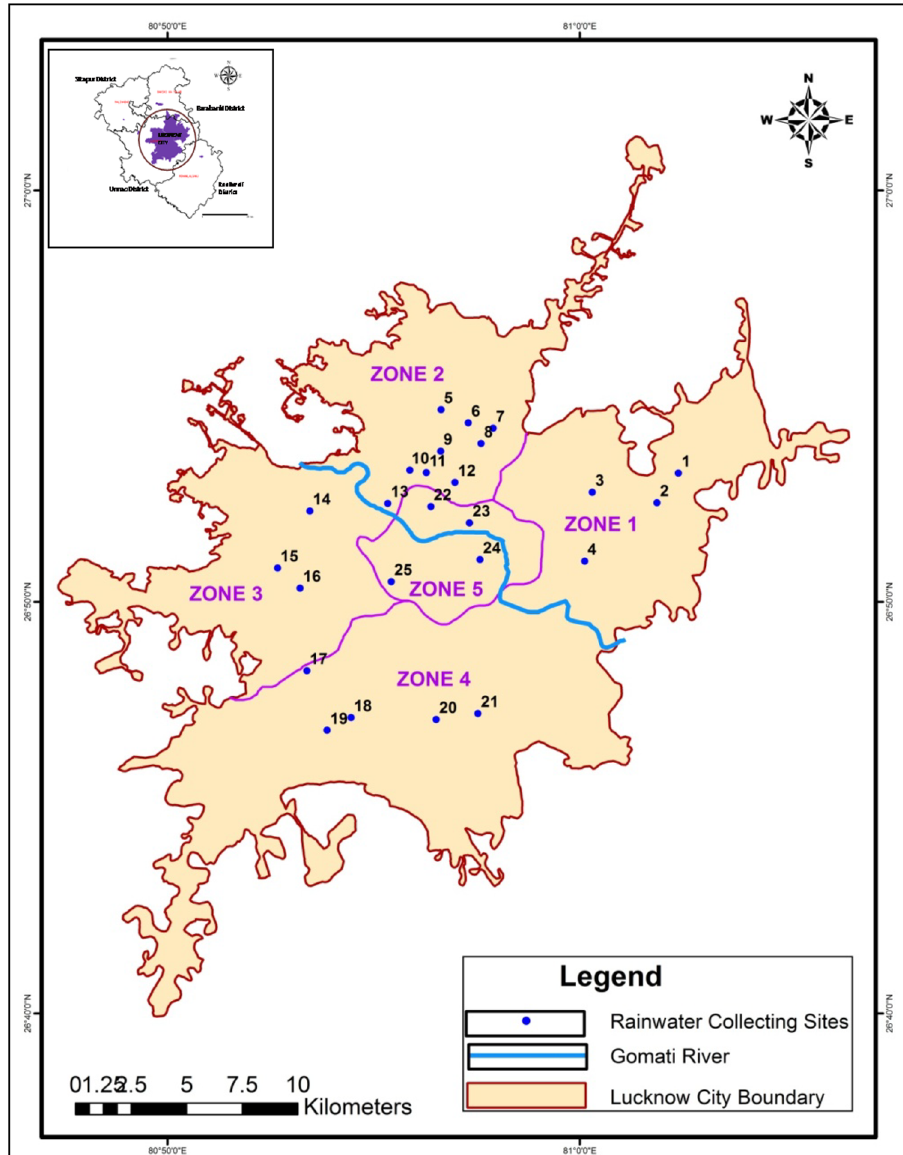
Fig. 3 Location of